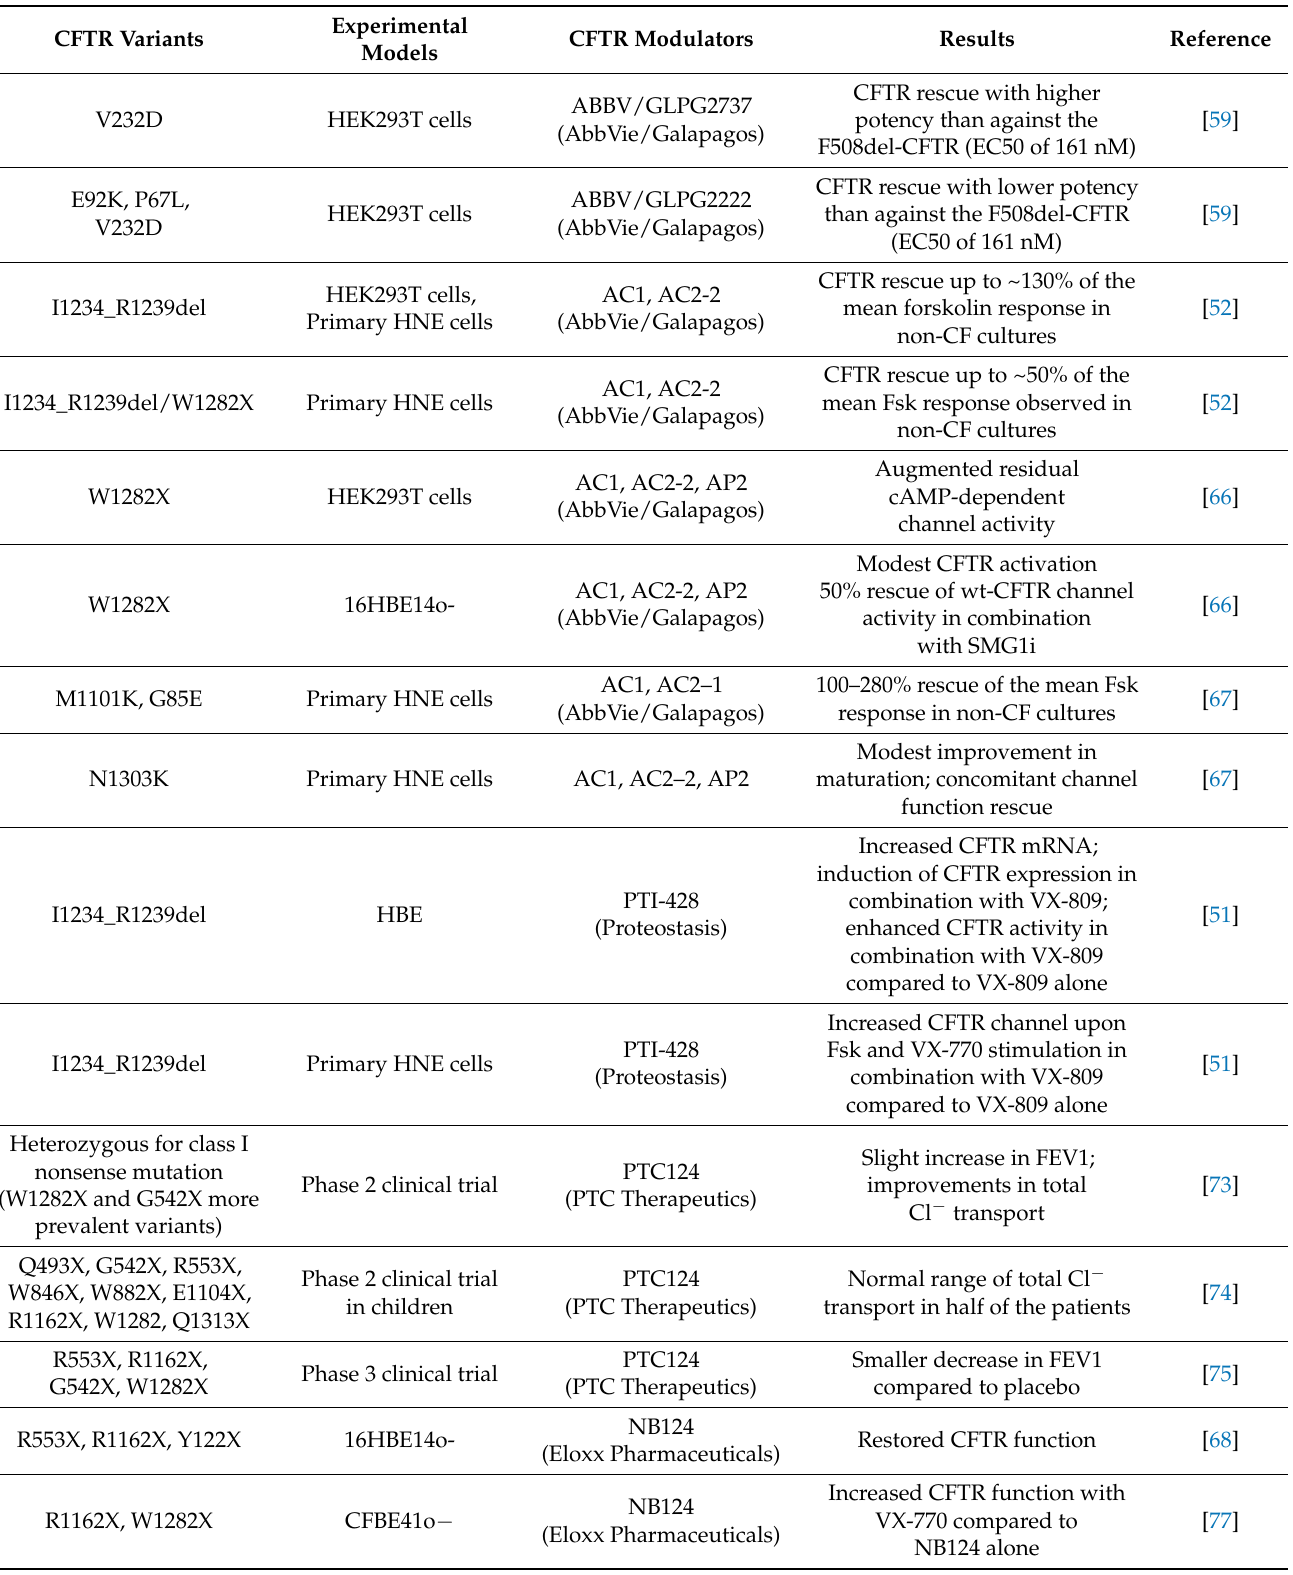
Table 2. Rare CFTR variants rescued by CFTR modulators under preclinical and clinical